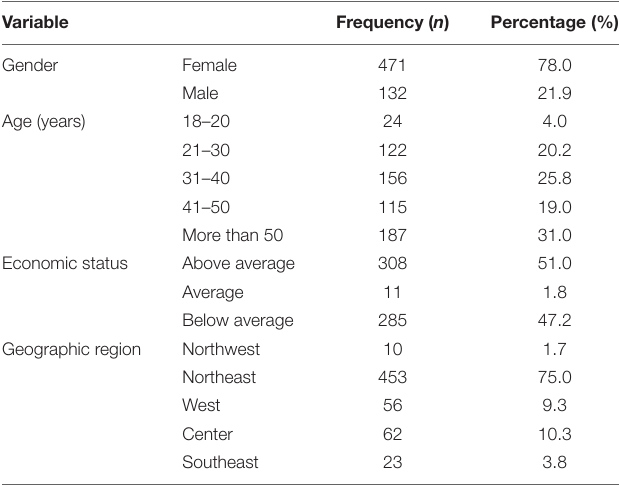
TABLE 1 | Sociodemographic variables and frequencies in the participants ( n = 604) of the study on the psychological effects of the COVID-19 pandemic on the Mexican